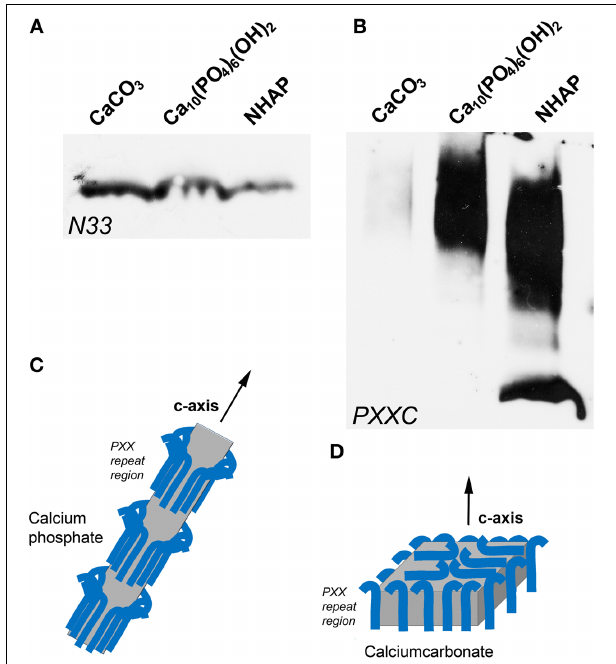
FIGURE 4 | Binding of amelogenin fragments to calcium minerals. (A,B) illustrate results from parallel experiments in which either an amelogenin N-terminal fragment (N33, A ) or a C-terminus augmented amelogenin repeat fragment (PXXC, B ) were incubated with three different calcium minerals, including calcium carbonate (CaCO 3 ), calcium phosphate, and nanohydroxyapatite (NHAP). (C,D) illustrates our explanation for the differences in calcium mineral crystal growth when subjected to different protein environments. Here we propose that polyproline repeat regions (blue hooks) as they occur in amelogenin bind to the a- and b- axis of calcium phosphate crystals and allow for the growth of long apatite crystal through expansion mostly in c-axis direction (C) . In contrast, proteins including polyproline peptides appear to affect calcium carbonate crystal growth equally in all directions, resulting in an overall compaction of the final crystal (D)